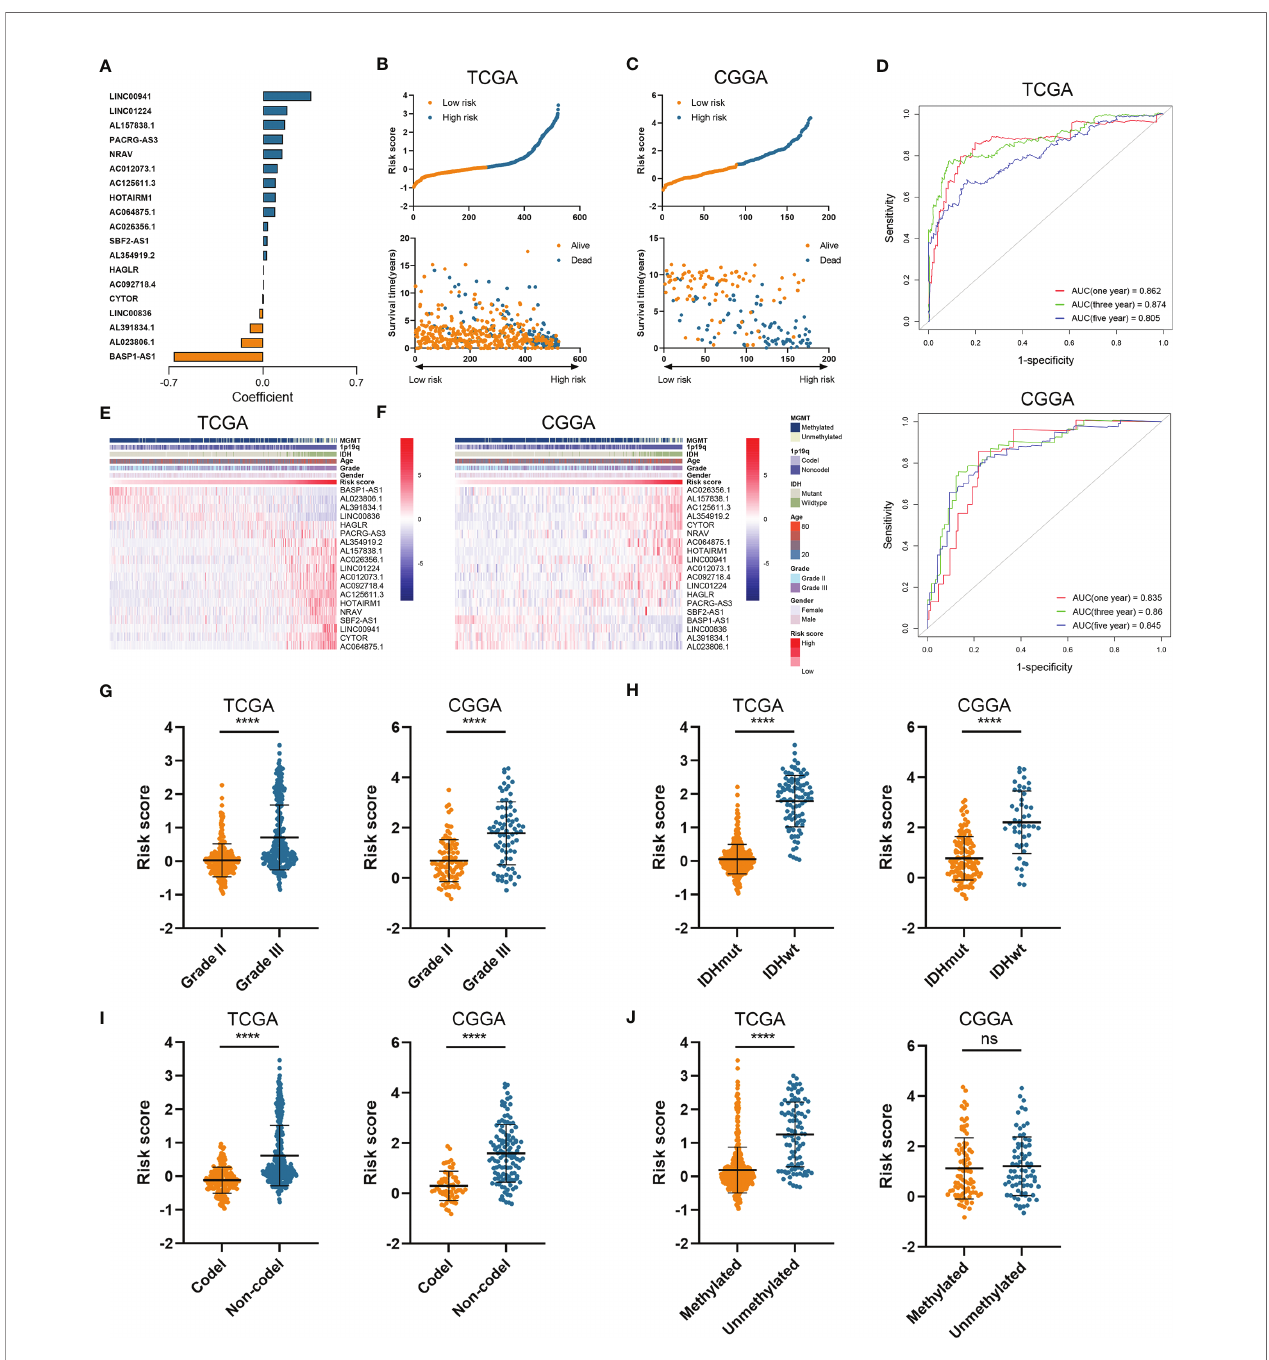
FIGURE 2 | Construction of risk signature based on the expression of HRLs. (A) The coef fi cient of 19 HRLs for the construction of risk signature. (B, C) The risk score and survival time of each sample in the TCGA (B) and CGGA (C) datasets. (D) Time-dependent ROC analysis of risk score in predicting 1-, 3-, and 5-year survival. (E, F) The expression of 19 HRLs in each sample from low risk to high risk in the TCGA (E) and CGGA (F) datasets. (G – J) The risk score in different grades (G) , IDH status (H) , 1p19q status (I) , and MGMT status (J) of gliomas in the two datasets. ****p < 0.0001; ns, no signi fi